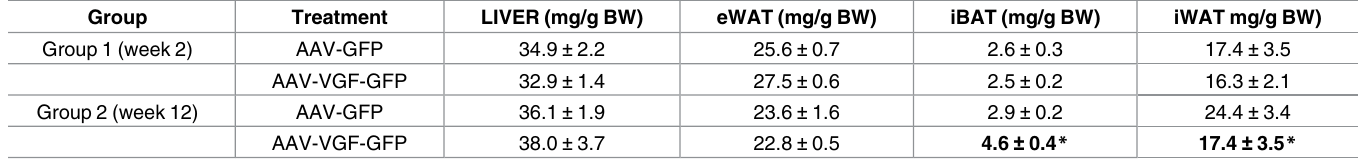
Table 2. Hypothalamic over-expression of VGF in Siberian hamsters increasesBAT weight and reduces interscapular white adipose tissue weight. Mean ( ± SEM) wet tissue weight (mg per g BW) in Siberianhamsters receivingbilateral AAV-GFP or AAV-VGF-GFP at 2 and 12 weeks post viral infusion. * p <